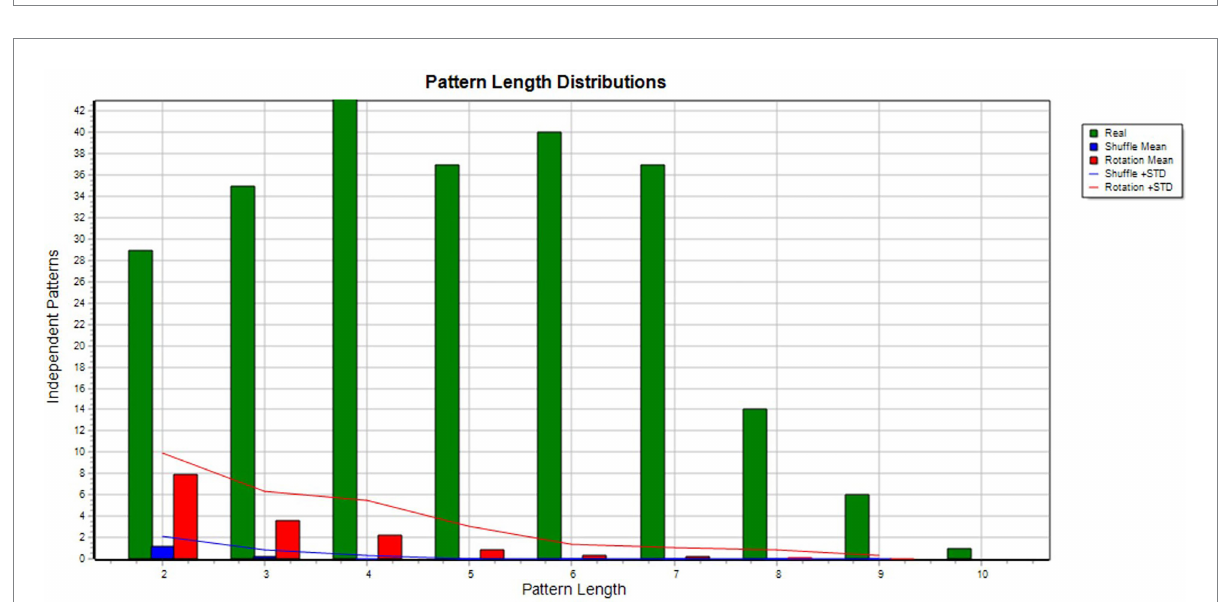
FIGURE 5 Monte Carlo test results. Shows the results of T-shuffling (blue) and T-rotation (red) for TPA of Julia and her mother interactions where 293 patterns were found. The difference between the real and randomized data is great and with longer patterns, none are found in the randomized